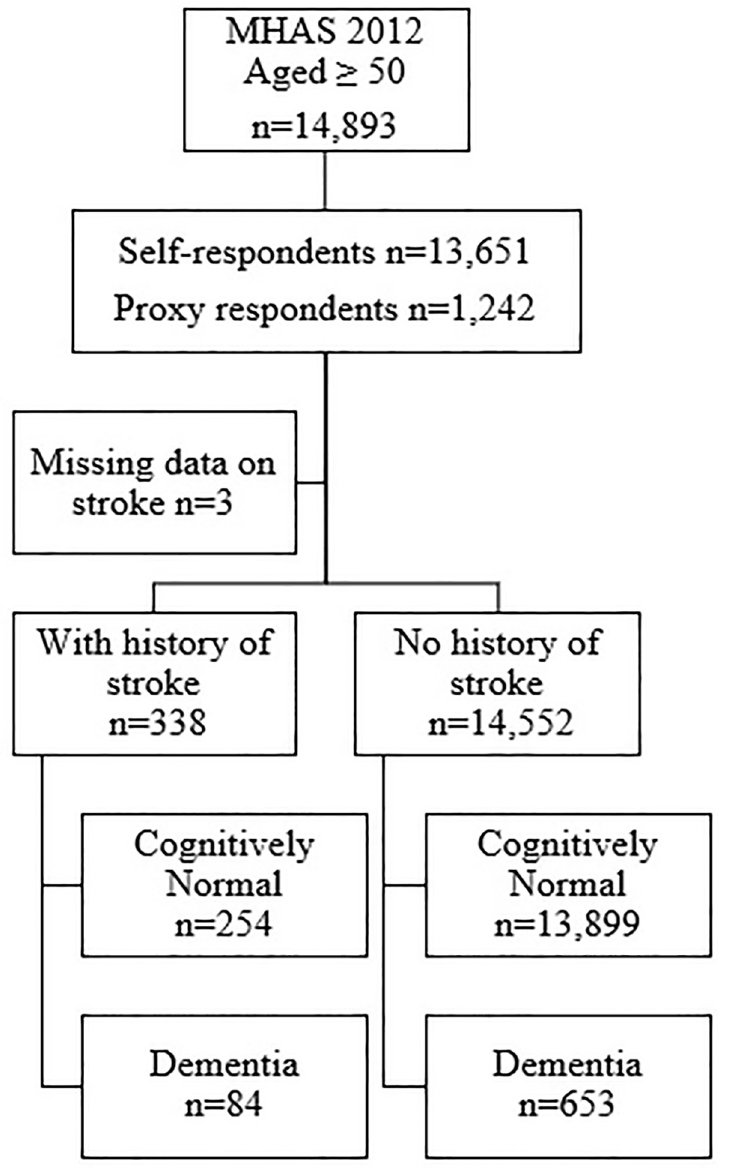
Fig 1. Flowchart of sample selection at baseline (MHAS